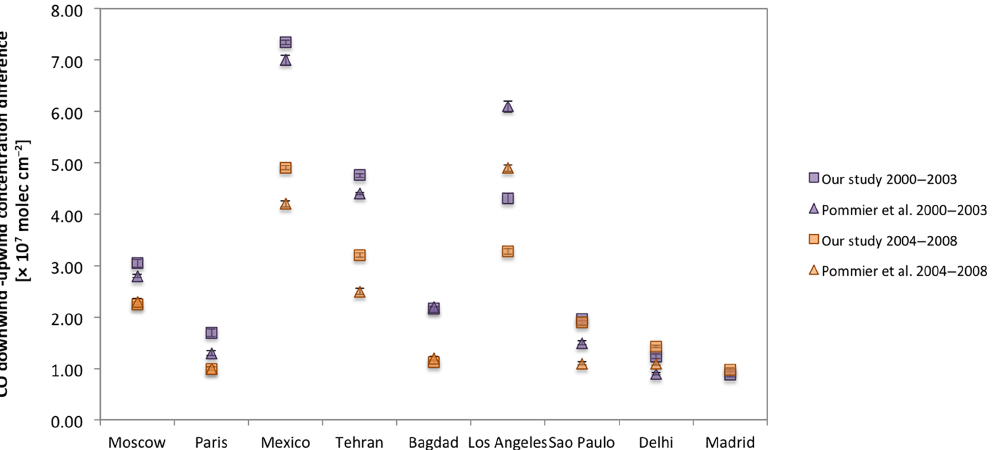
Figure 4. Total column CO concentration downwind minus upwind of selected cities (see Sect. 2), comparing our study using MOPITT version 5 (squares) and the study of Pommier et al. (2013, triangles). Error bars represent uncertainties calculated according to P13.